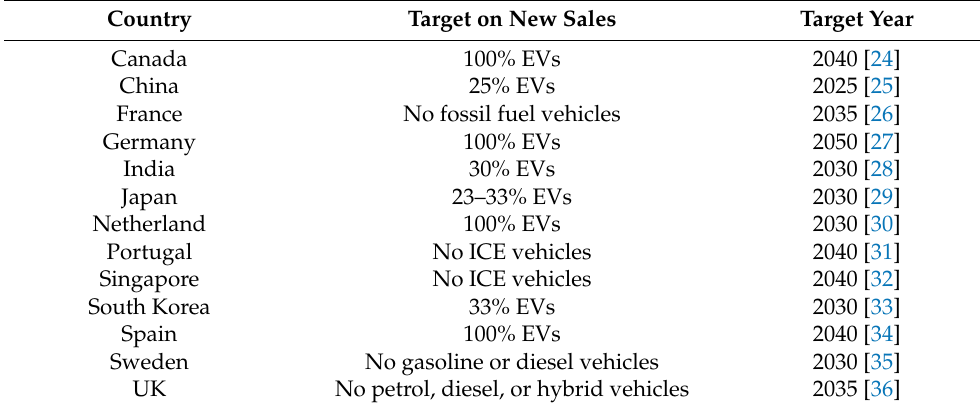
Table 1. Electric vehicle targets set by various countries